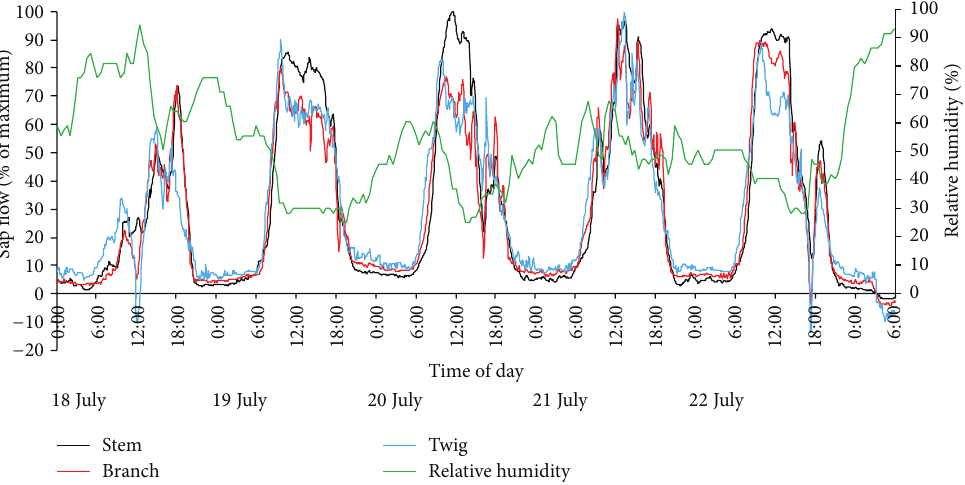
Figure 5: Five days of sap flows at the three different positions on the T. ramosissima plant and air relative humidity under natural conditions. Data from the control group synchronize with the treatment